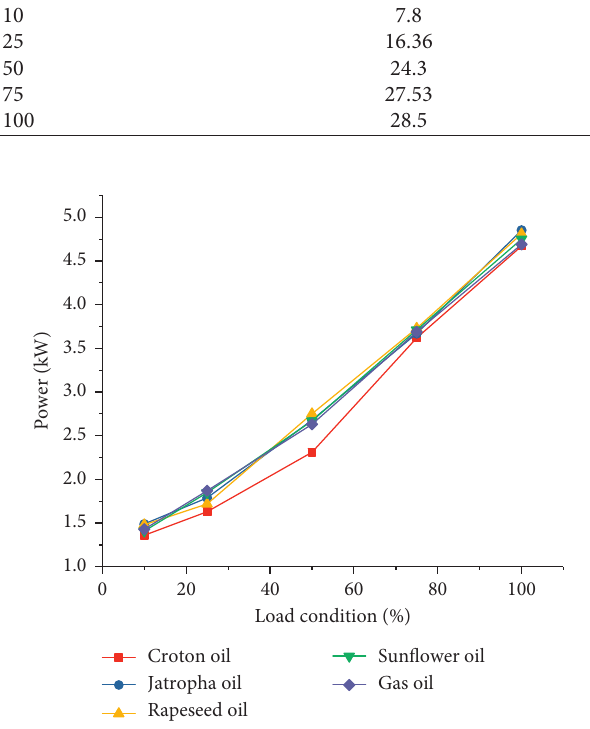
Figure 3: Recovered exhaust gas heat for cogeneration [27].